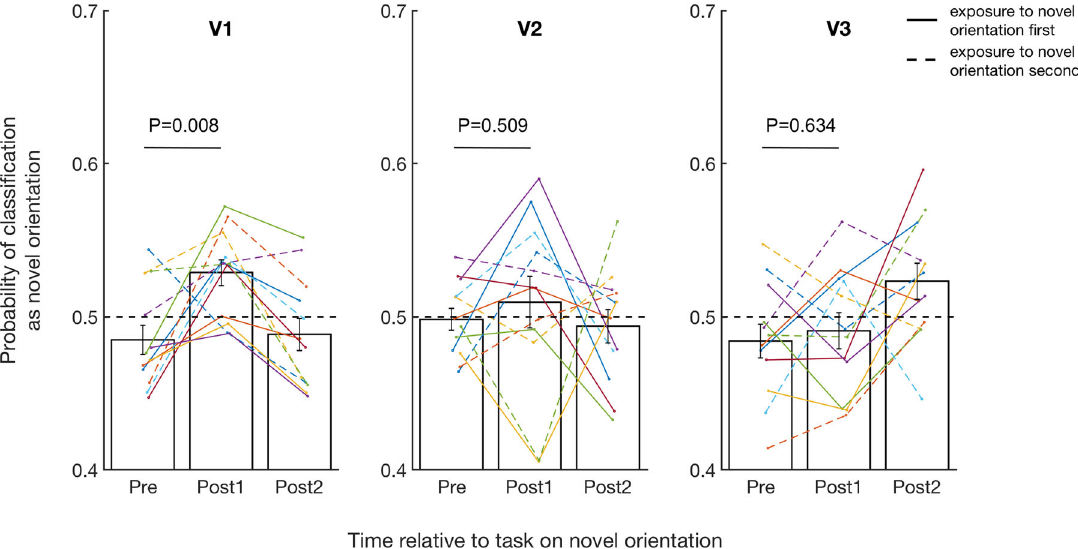
Fig. 2 Probability that neural patterns are classi fi ed as the novel orientation before and after exposure to the novel orientation. Brain activity was more likely to be classi fi ed as the novel orientation in V1 shortly after exposure to the novel orientation. This effect was absent in both V2 and V3. “ Pre ” refers to two initial scans before subjects saw any stimuli (5 min/scan; combined into a single “ pre ” baseline). “ Post1 ” and “ post2 ” refer to the fi rst and the second post-task scans immediately after exposure to the novel orientation. The solid and dashed lines represent subjects who were exposed to the novel orientation fi rst and second, respectively. The P values in the fi gure refer to the results of paired t tests between pre and post1. Error bars indicate s.e.m. N =